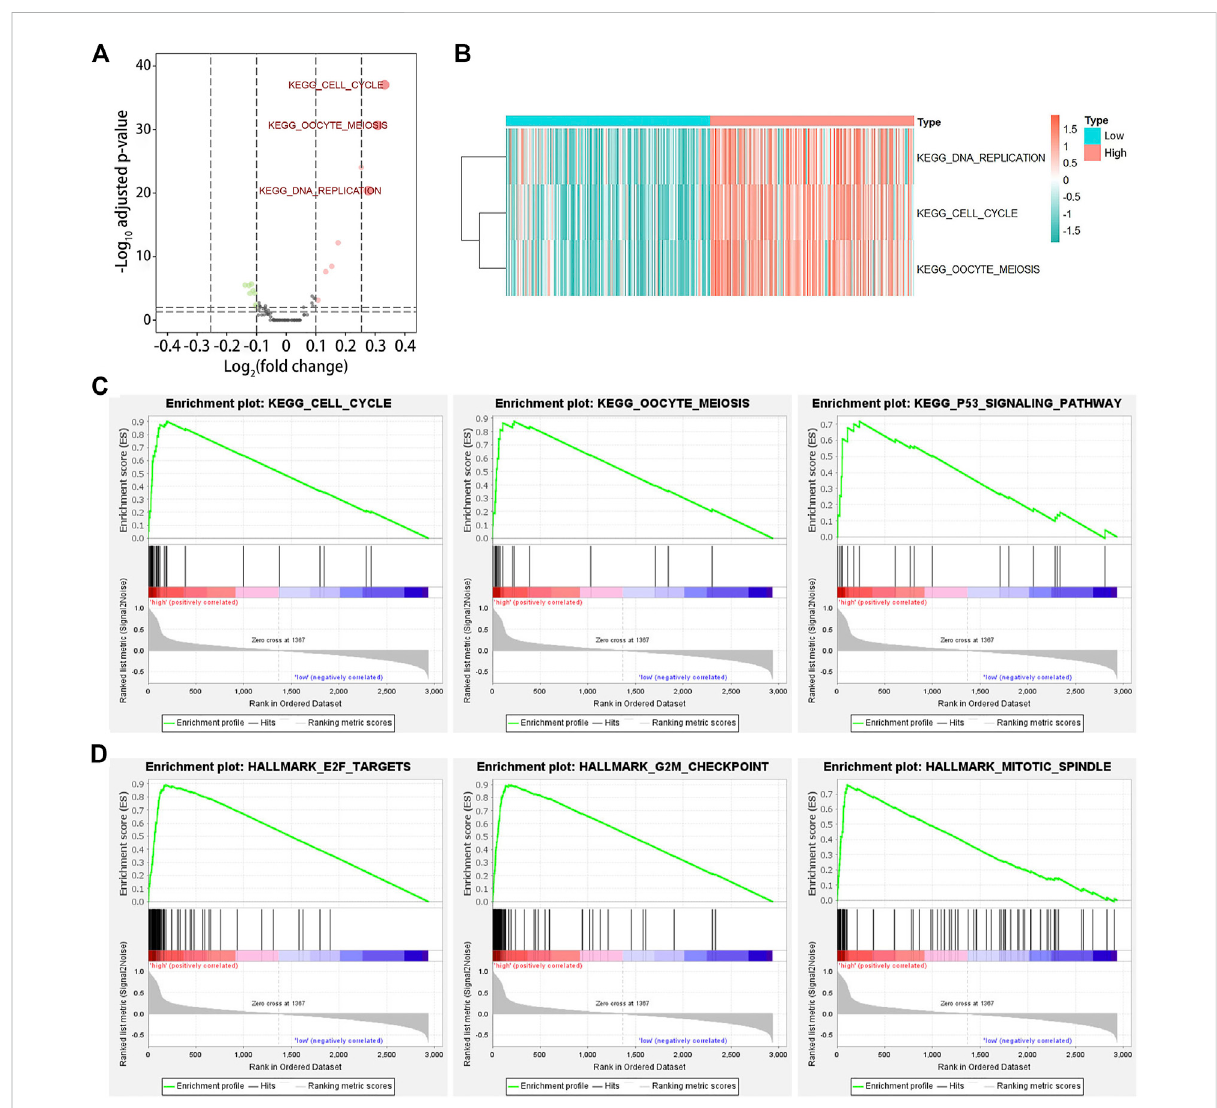
FIGURE 8 Gene set variation analysis (GSVA) and gene set enrichment analysis (GSEA). Image (A) illustrates the identi fi cation of differentially expressed pathways among LUAD patients by GSVA. LUAD patients were divided into low and high KIF20A expression subgroups based on the median KIF20A expressionlevel.Anadjusted p -value < 0.05andlog 2 |foldchange| > 0.25weresetasthecutoffcriterion.Image (B) showstheclusteringheatmapfor thedifferentiallyexpressedpathways.Image (C) showstheenrichedgenesetsinKEGG,whileimage (D) showstheHALLMARKcollectionsinthe high KIF20A expression